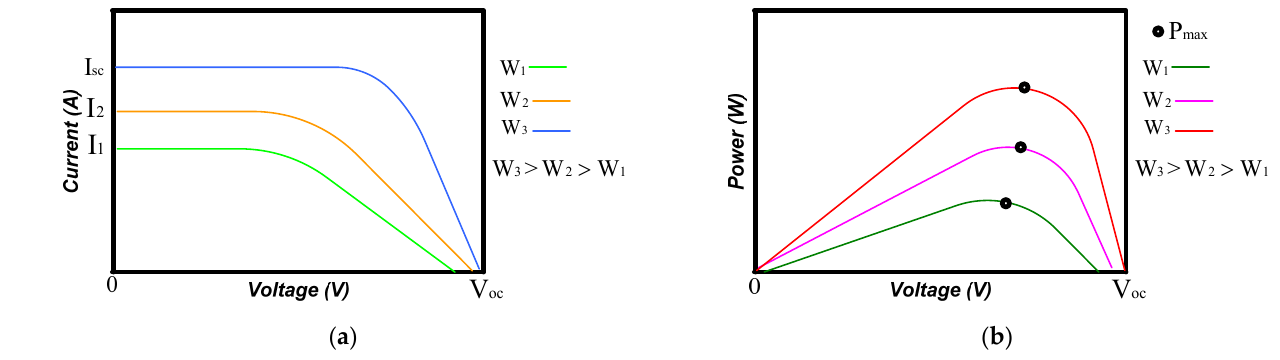
Figure 5. Irradiance variation effect on PV module: ( a ) I–V curve and ( b ) P–V curve.